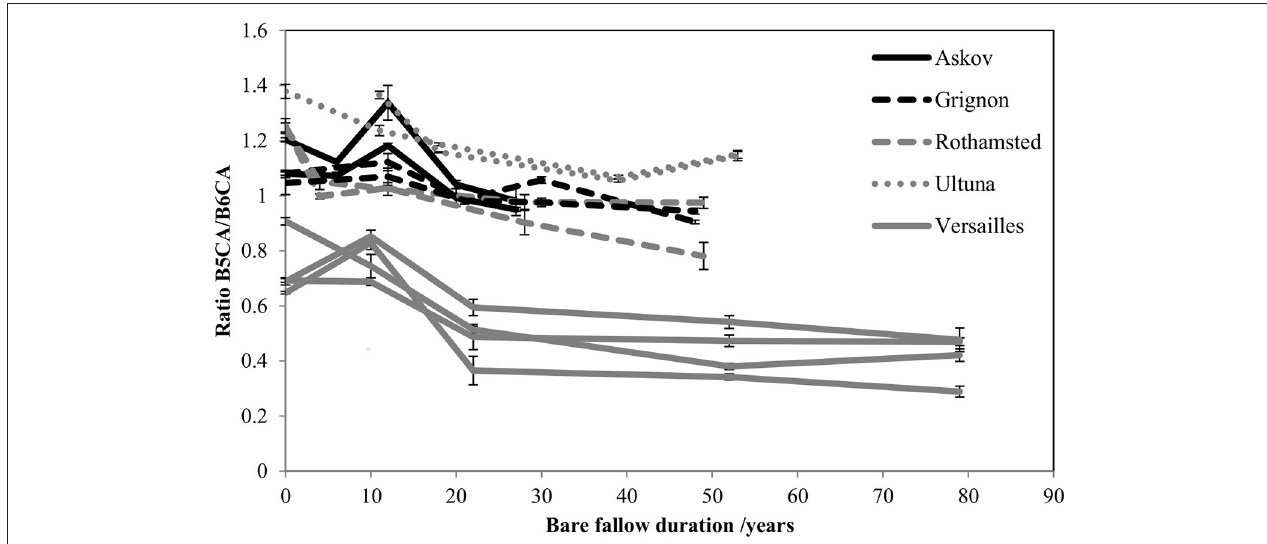
FIGURE 2 | Consistent qualitative evolution of PyOC at all LTBF sites. Evolution of the ratio between the quantities (mg PyOC-C g − 1 soil) of two molecular markers (B5CA and B6CA) out of the four molecular markers analyzed with the BPCA method. Error bars represent the variability observed between technical replicates.